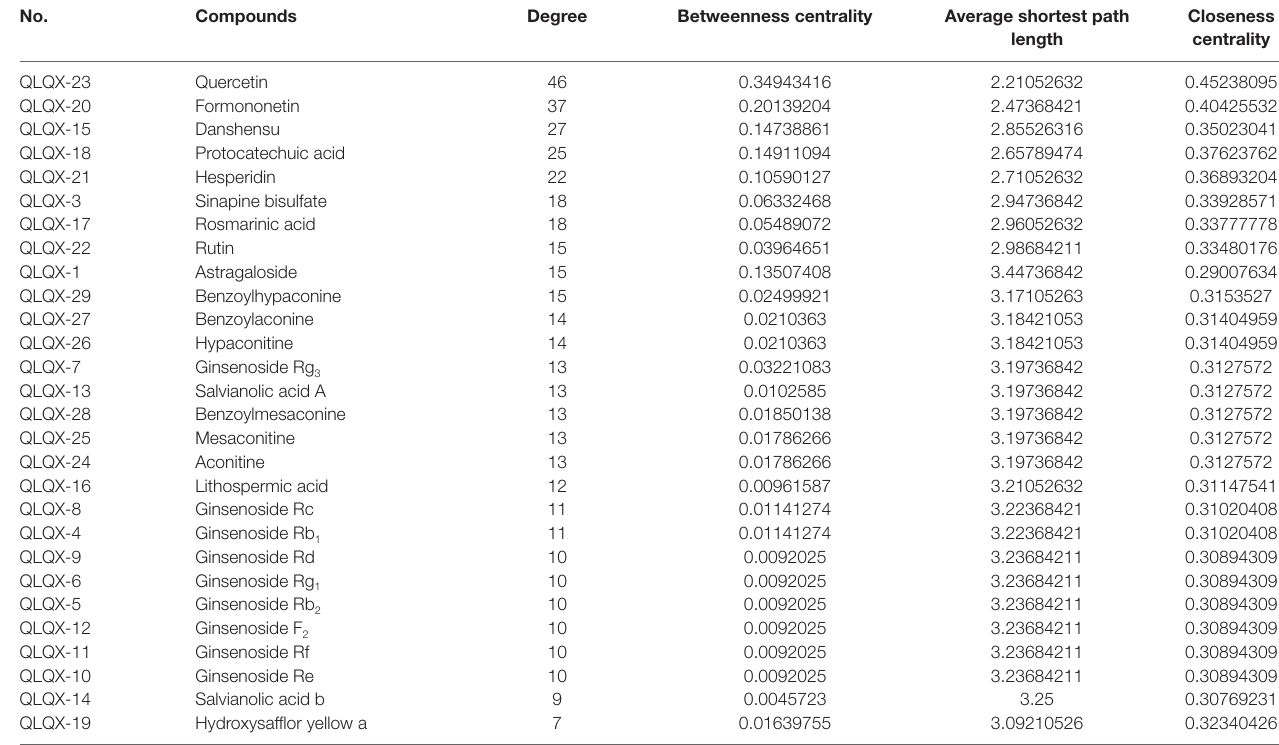
TABLE 3 | The topological parameters of 28 main active components.